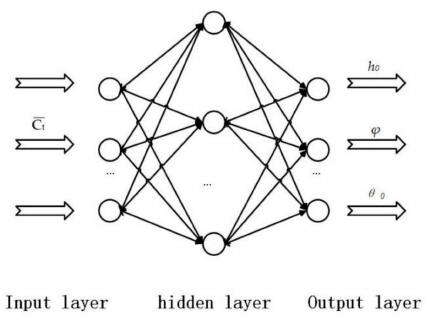
Figure 14. Schematic diagram of the BP neural network structure.